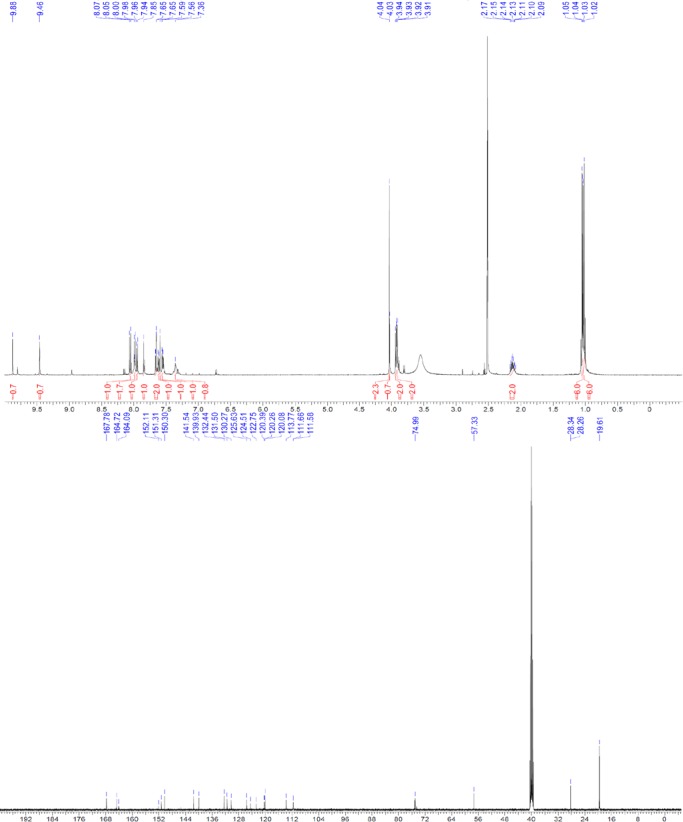
1H and 13C NMR of ERX-7.